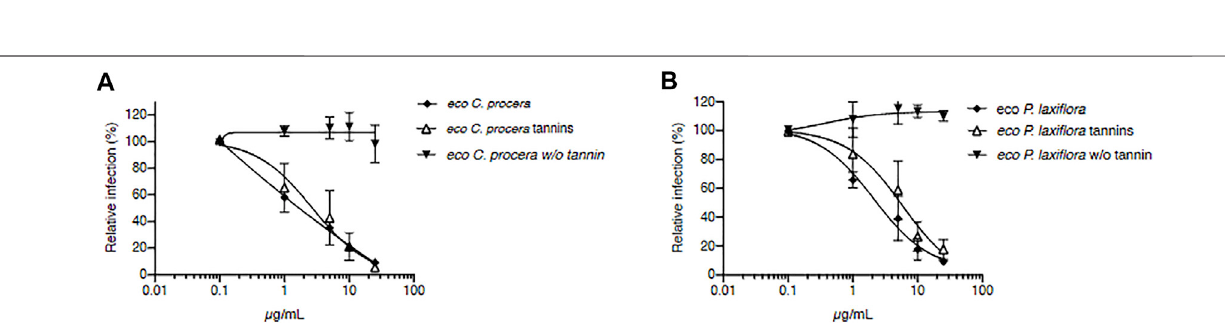
Frontiers in Pharmacology |